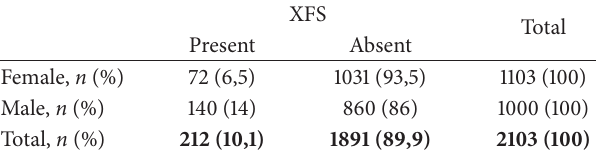
Table 3: XFS rate by sex.